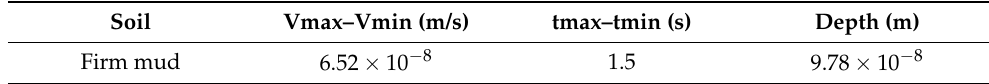
Table 1. Velocity and depth